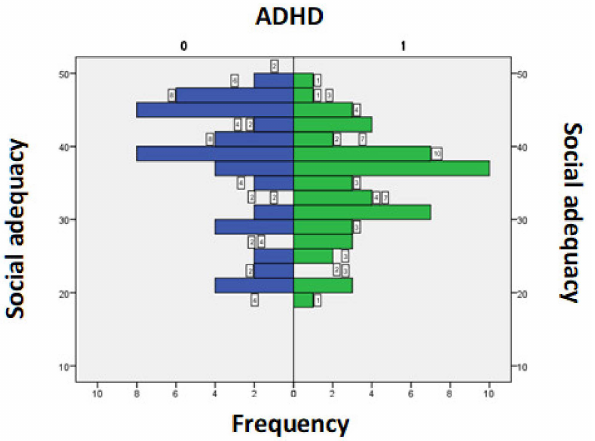
Figure 3. Score for the field of Social Adequacy according to the presence/absence of ADHD symptoms.